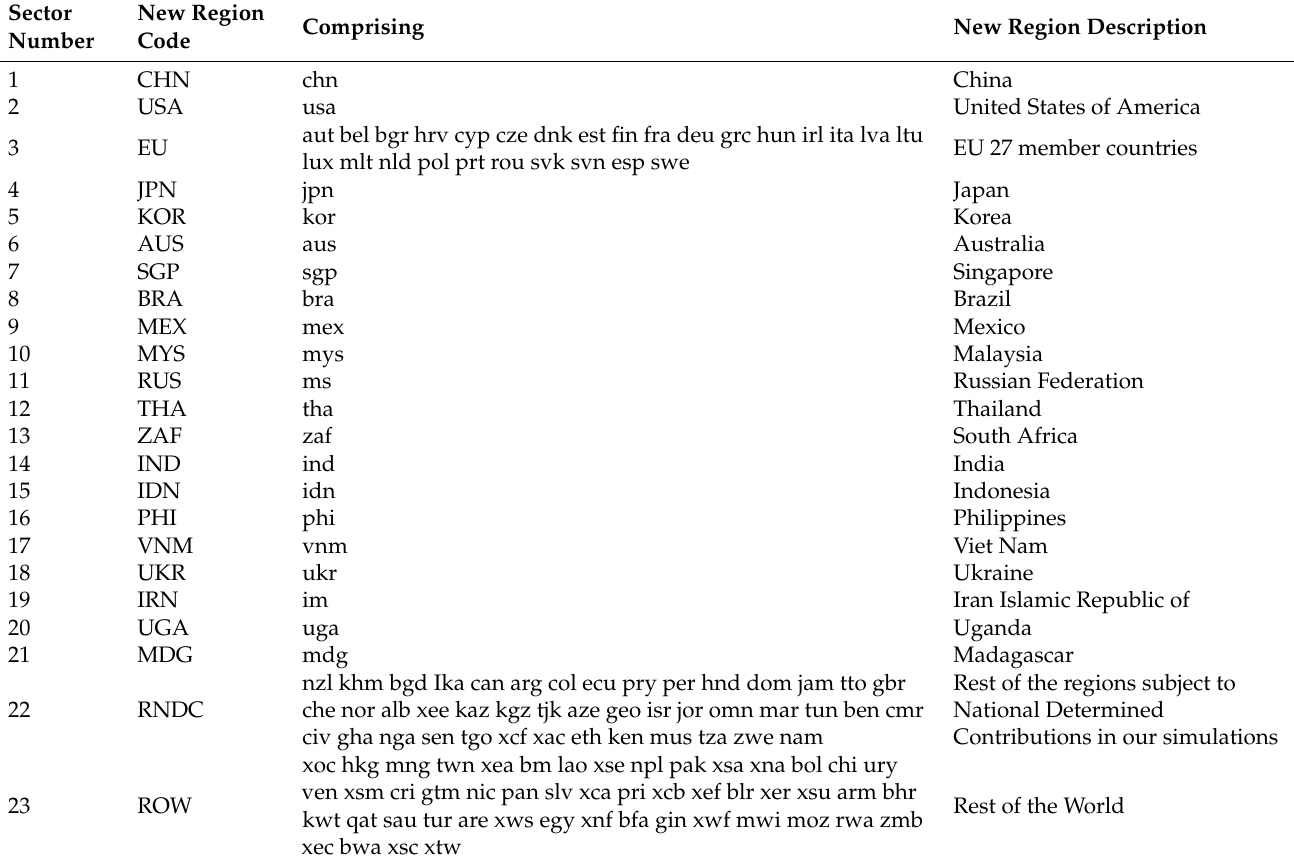
Table 3. Regions used in the